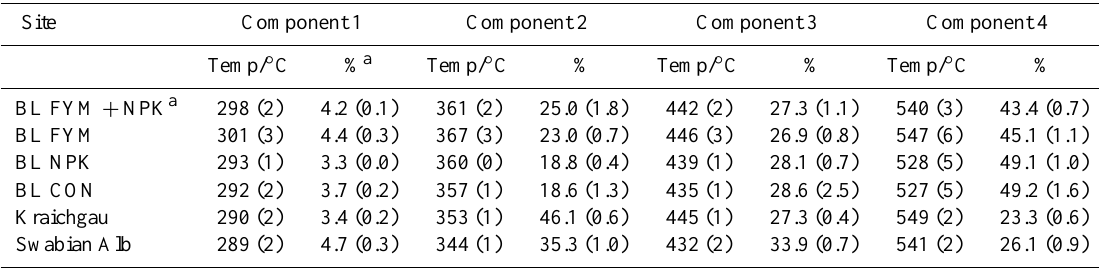
Table 5. Temperature and relative contribution to total evolved CO 2 of fitted peaks/components ( ± standard errors) from an iterative least squares approach of thermally evolved CO 2 from 25 to 700 ◦ C (68 ◦ Cmin − 1 heating rate) as measured by FTIR-EGA. Peak temperatures of the components were derived from relative changes of vibrational intensity of organic functional groups by in situ T